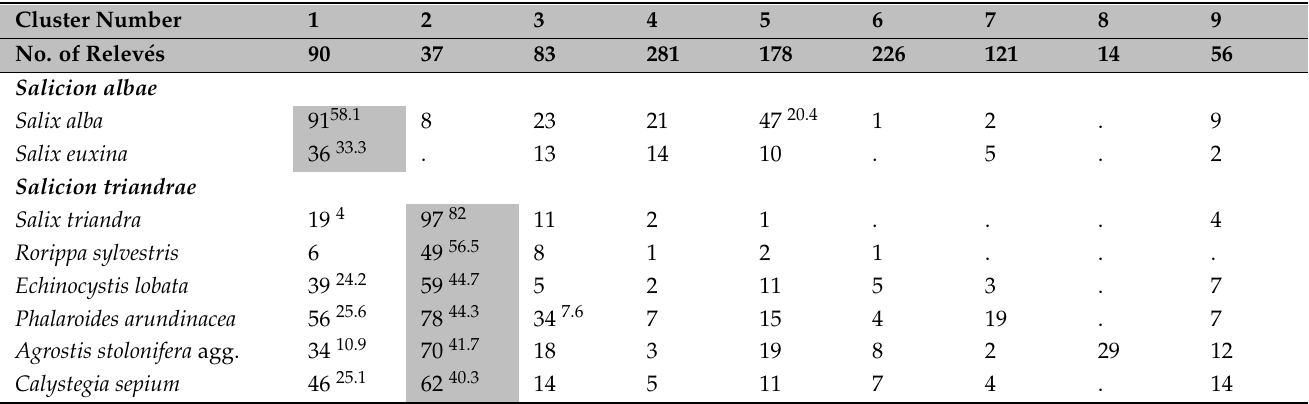
Table 1. Synoptic table of WFS types in the Western Balkans. Frequencies of species are presented as percentages with phi values multiplied by 100 shown in superscript. Diagnostic species (phi values higher than 0.30) are shaded. Diagnostic species are sorted by decreasing fidelity. Species with a frequency lower than 30% in a cluster for which they are diagnostic are not shown.